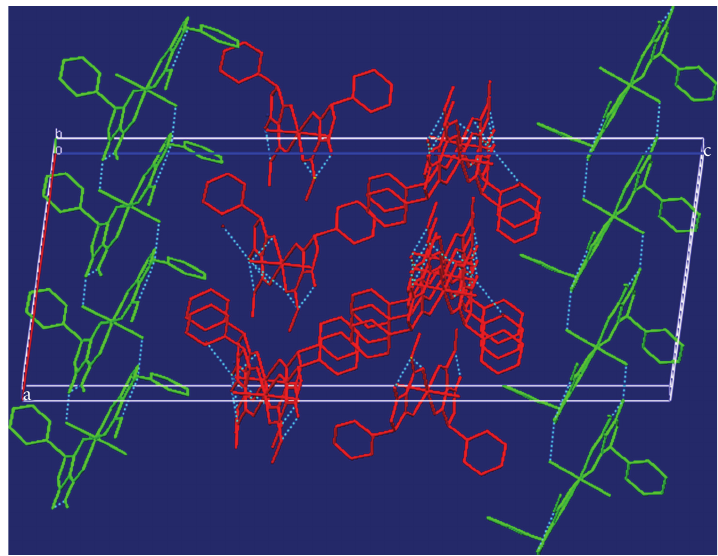
Figure 3: Zn1 chains (red) and Zn2 chains